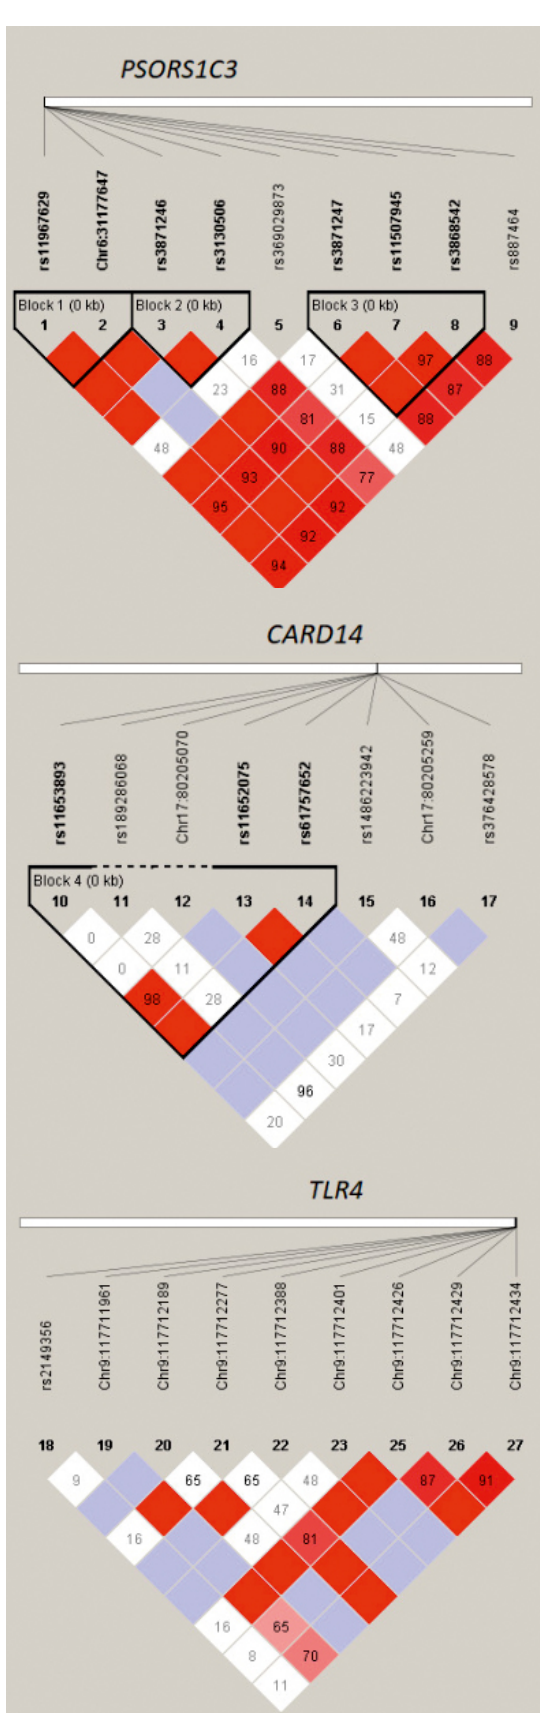
Figure 4 – Linkage disequilibrium (LD) analysis of TLR4, CARD14 and PSORS1C3 genes in psoriatic patients and controls. Linkage disequilibrium analysis shows the genotyped variants in PSORS1C3, CARD14 and TLR4 genes. D’ value was shown in the LD